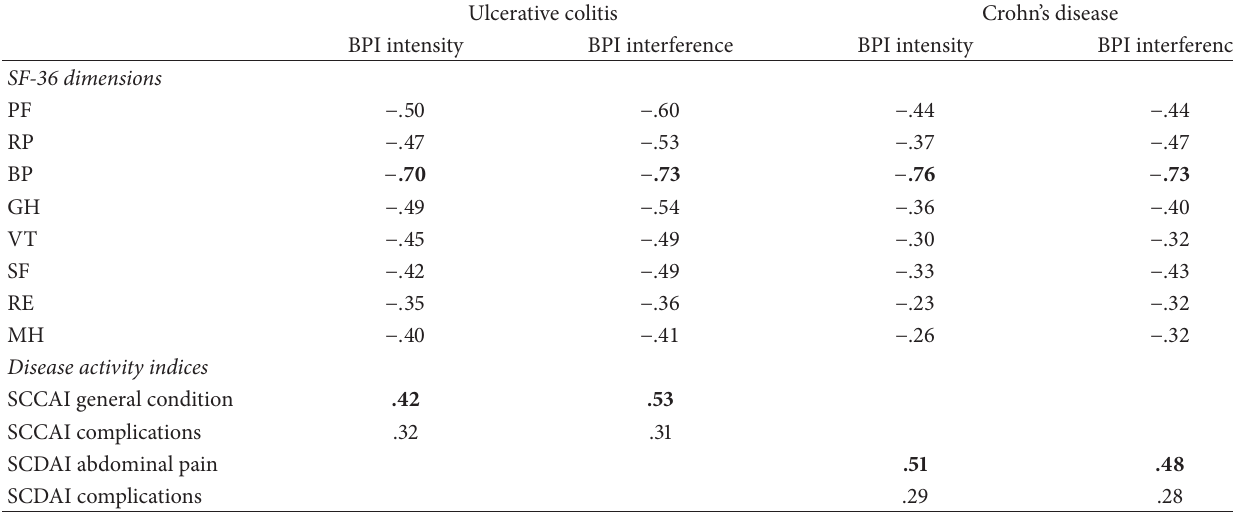
Table 3: Spearman correlation between the BPI dimensions, the dimensions of the short-form 36 (SF-36), and disease activity indices. Ulcerative colitis